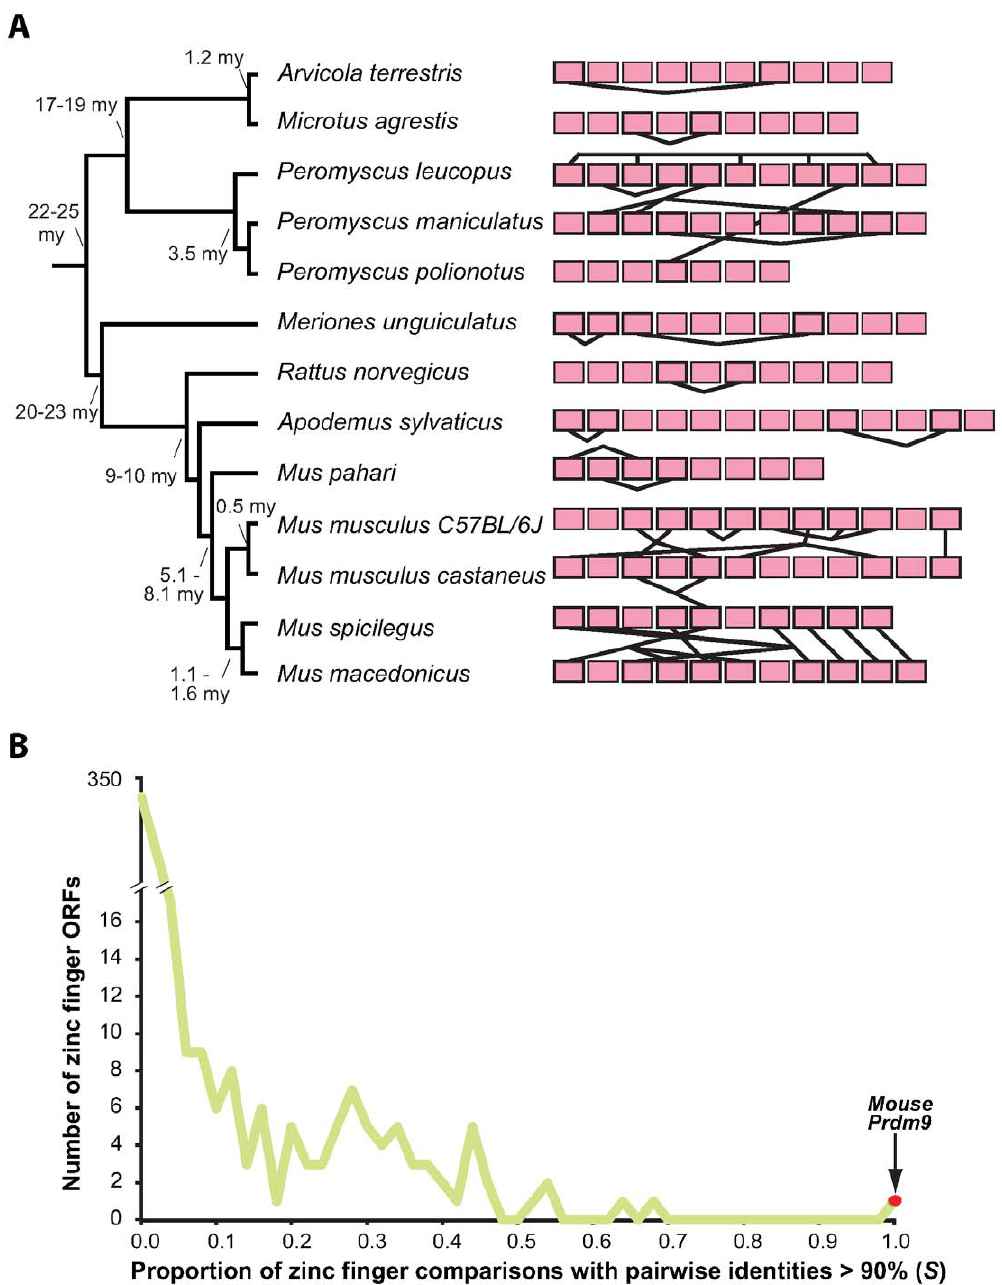
Figure 2. Concerted evolution among rodent Prdm9 genes. (A) Prdm9 C-terminal zinc fingers for 13 rodent species are shown as pink rectangles. Zinc fingers whose nucleotide sequences are identical are joined by solid lines. Zinc fingers with identical sequences from the same species are consistent with gene conversion and/or intra-exon duplication. A phylogeny of these species is also shown with estimated divergence dates (indicated at nodes) given in millions of years (my) [20,83]. Common names to species are listed in the legend to Figure 6. (B) The proportion of pairwise cDNA comparisons between aligned zinc fingers from the same gene (see Materials and Methods) which show greater than 90% identity. All mouse Prdm9 zinc fingers are more than 90% identical to all other C-terminal zinc fingers in the same protein (indicated in red), a much higher fraction than for any other zinc finger protein encoded by the mouse genome.